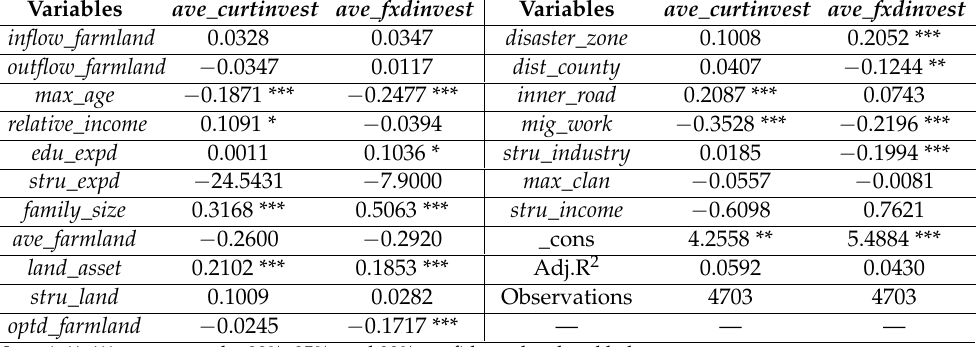
Table 2. The regression result of farmland transfer on farmer’s productive